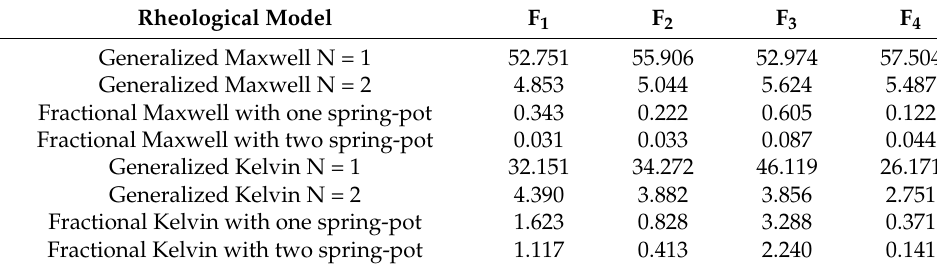
Figure 6. Experimental values of the storage and the loss modulus and generalized Maxwell and Kelvin models (N = 1 and N = 2), fractional Maxwell models with one and two spring-pots, and fractional Kelvin models with one and two spring pots: ( a ) F1; ( b ) F2; ( c ) F3; ( d ) F4. (GMN1: Generalized Maxwell model (N = 1); GMN2: Generalized Maxwell model (N = 2); FMOS: Fractional Maxwell Model with One Spring-pot; FMTS: Fractional Maxwell Model with Two Spring-pots; GKN1: Generalized Kelvin model (N = 1); GKN2: Generalized Kelvin model (N = 2); FKOS: Fractional Kelvin Model with One Spring-pot; FKTS: Fractional Kelvin Model with Two Spring-pots.) Table 2. Optimal values F min